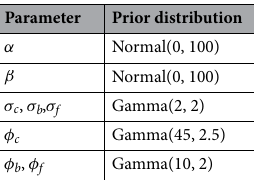
Table 1. Prior distributions used for the parameters of the Bayesian logistic common-components geostatistical